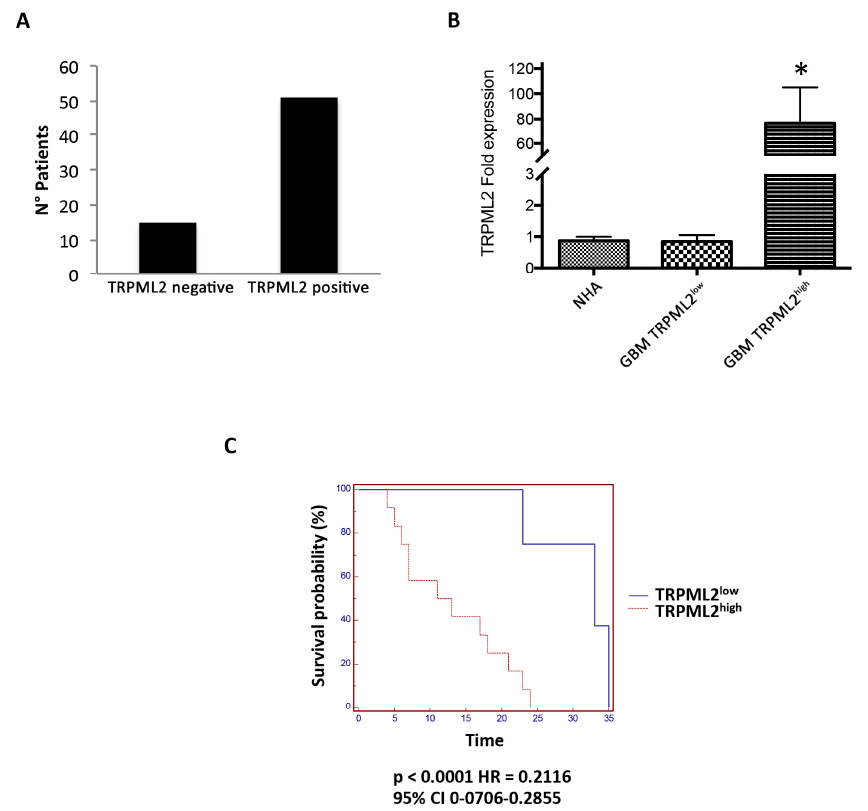
Figure 9. TRPML2 overexpression correlates with poor prognosis in GBM patients. ( A ) Number of patients TRPML2 negative and TRPML2 positive. ( B ) The relative TRPML2 mRNA expression in normal human astrocyte (NHA), and GBM samples expressing low (n = 18) or high (n = 33) TRPML2 was evaluated by qRT-PCR. TRPML2 mRNA levels were normalized for GAPDH expression. Data are expressed as the mean ± SD. * p < 0.01 vs. NHA and TRPML2 low samples. ( C ) Kaplan–Meier plot for GBM patients in TRPML2 low and TRPML2 high subgroups. p <